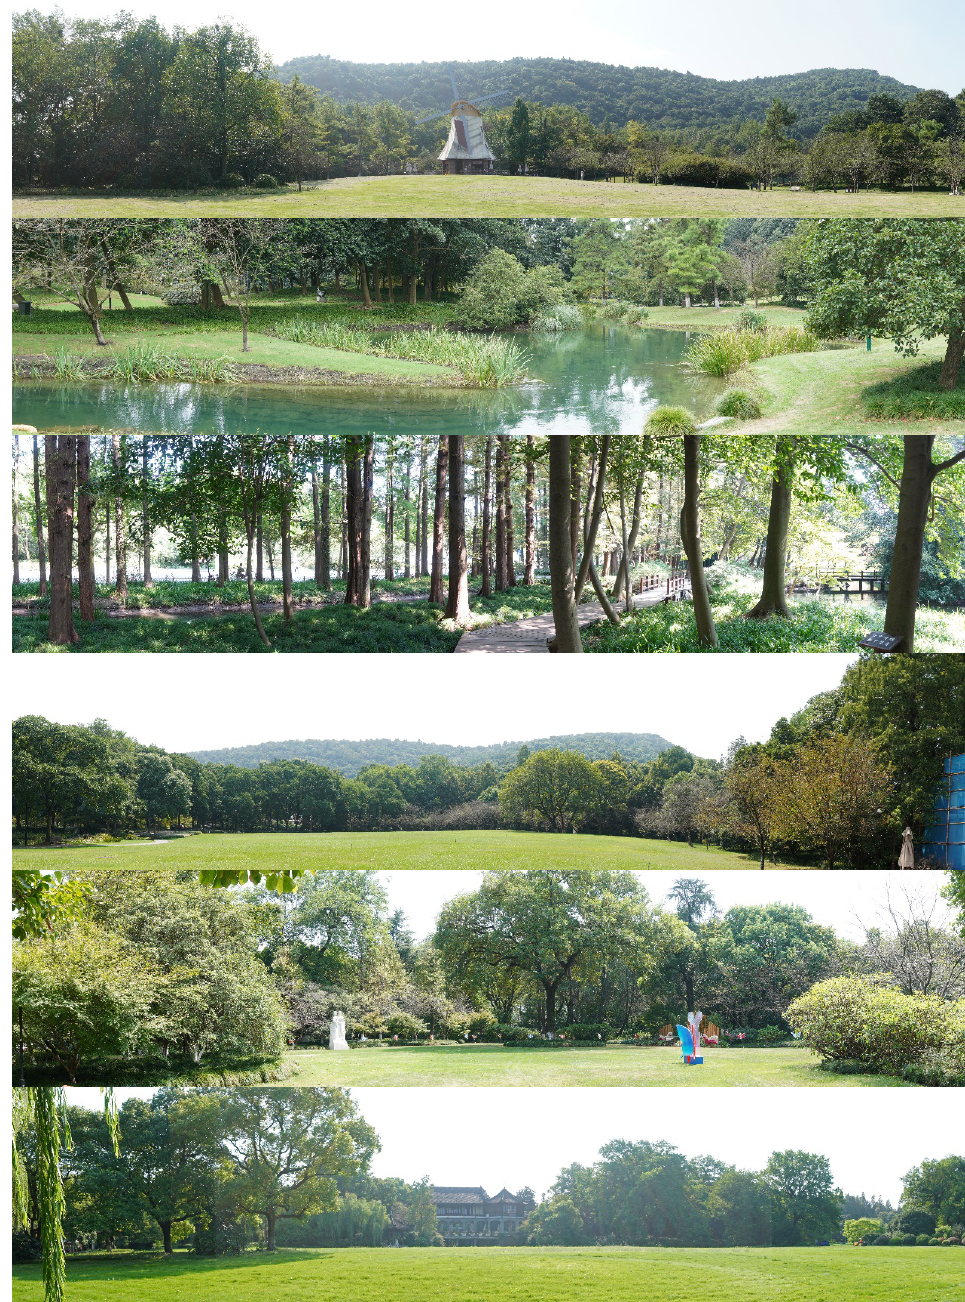
Figure A1. 15 horizontal panoramic photos and the website address of 15 360° panoramic videos. http://view.vryun.work/#/panoview/50227 [Online; accessed on 6 August 2021]. http://view.vryun.work/#/panoview/50226 [Online; accessed on 6 August 2021].